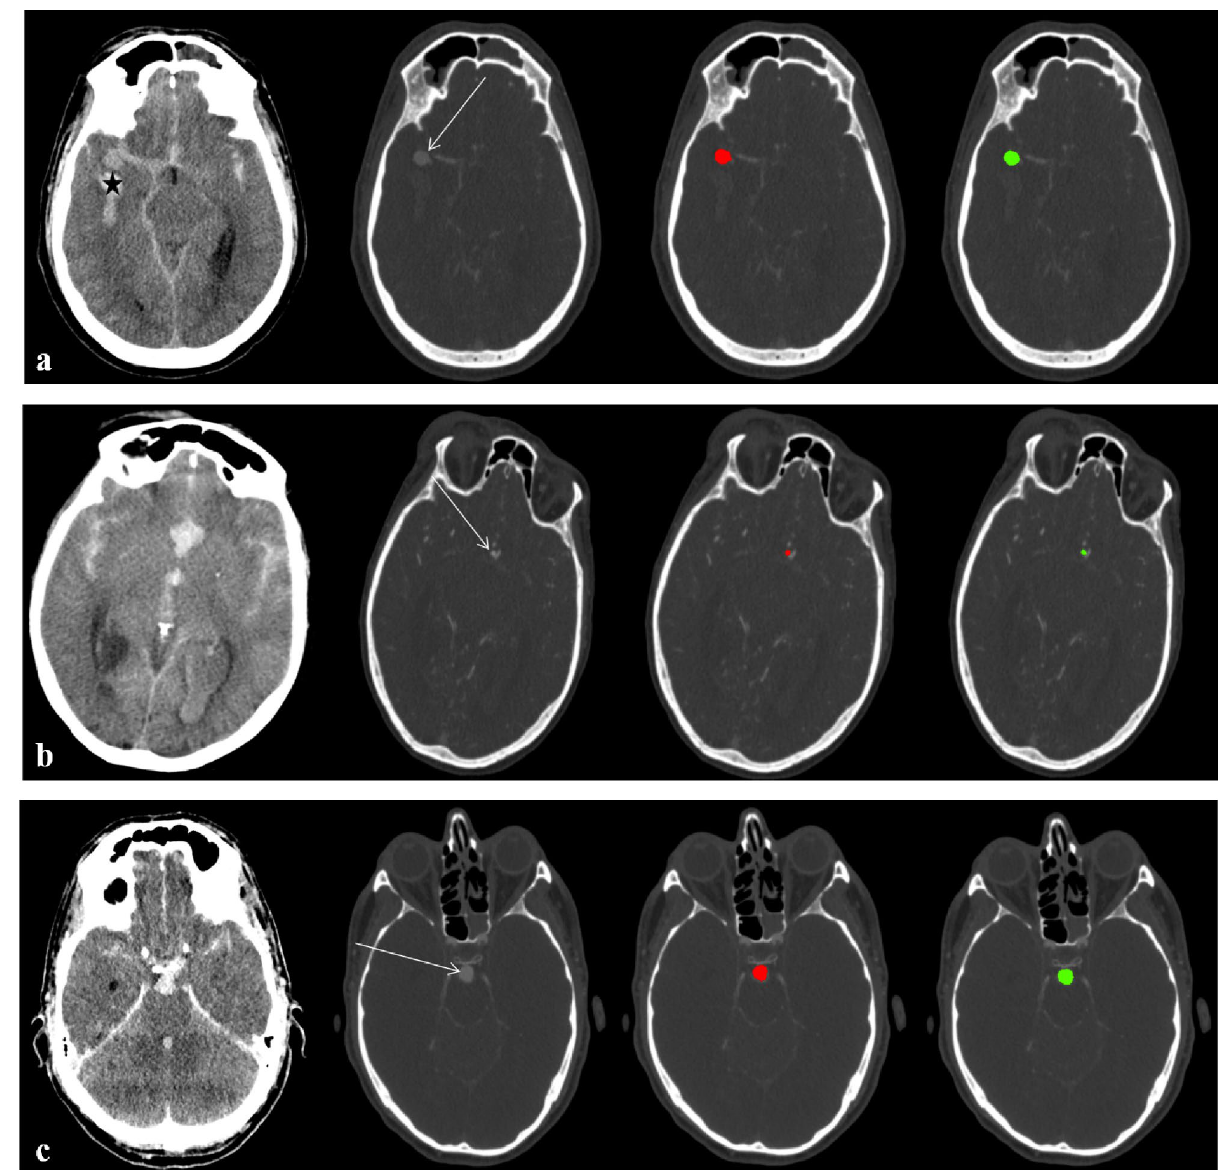
(green) detects and segments the aneurysm (volume based on manual segmentation: 424.7 mm 3 ) with high overlap (DSC of 0.94) compared to manual segmentations (red). ( b ) Sixty-three-year-old female with aSAH on axial unenhanced CT and an anterior communicating artery aneurysm (arrow) on axial CTA source images. Albeit being of small size (volume based on manual segmentation: 25.5 mm 3 ), the DLM-Ens (green) detects and segments (DSC of 0.72) the aneurysm with high overlap compared to manual segmentations (red). ( c ) Fifty- one-year-old male with aSAH on axial unenhanced CT and a large basilar tip aneurysm (arrow; volume based on manual segmentation 419.6 mm 3 ) on axial CTA source images. Compared to manual segmentations (red), the DLM-Ens (green) provides accurate detection and segmentation (DSC of